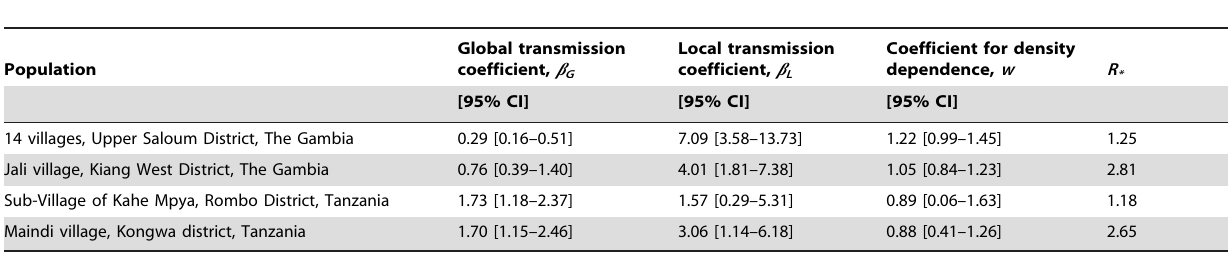
Table 2. Maximum likelihood estimates of the transmission parameters in four populations of West and East Africa.